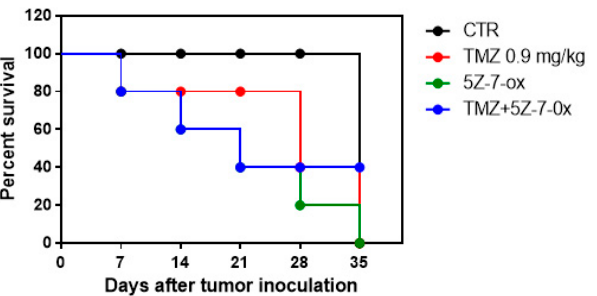
Figure 7. Survival curve in vivo. Kaplan–Meier survival analysis of C57BL/6 wild-type mice implanted with U87MG cells.